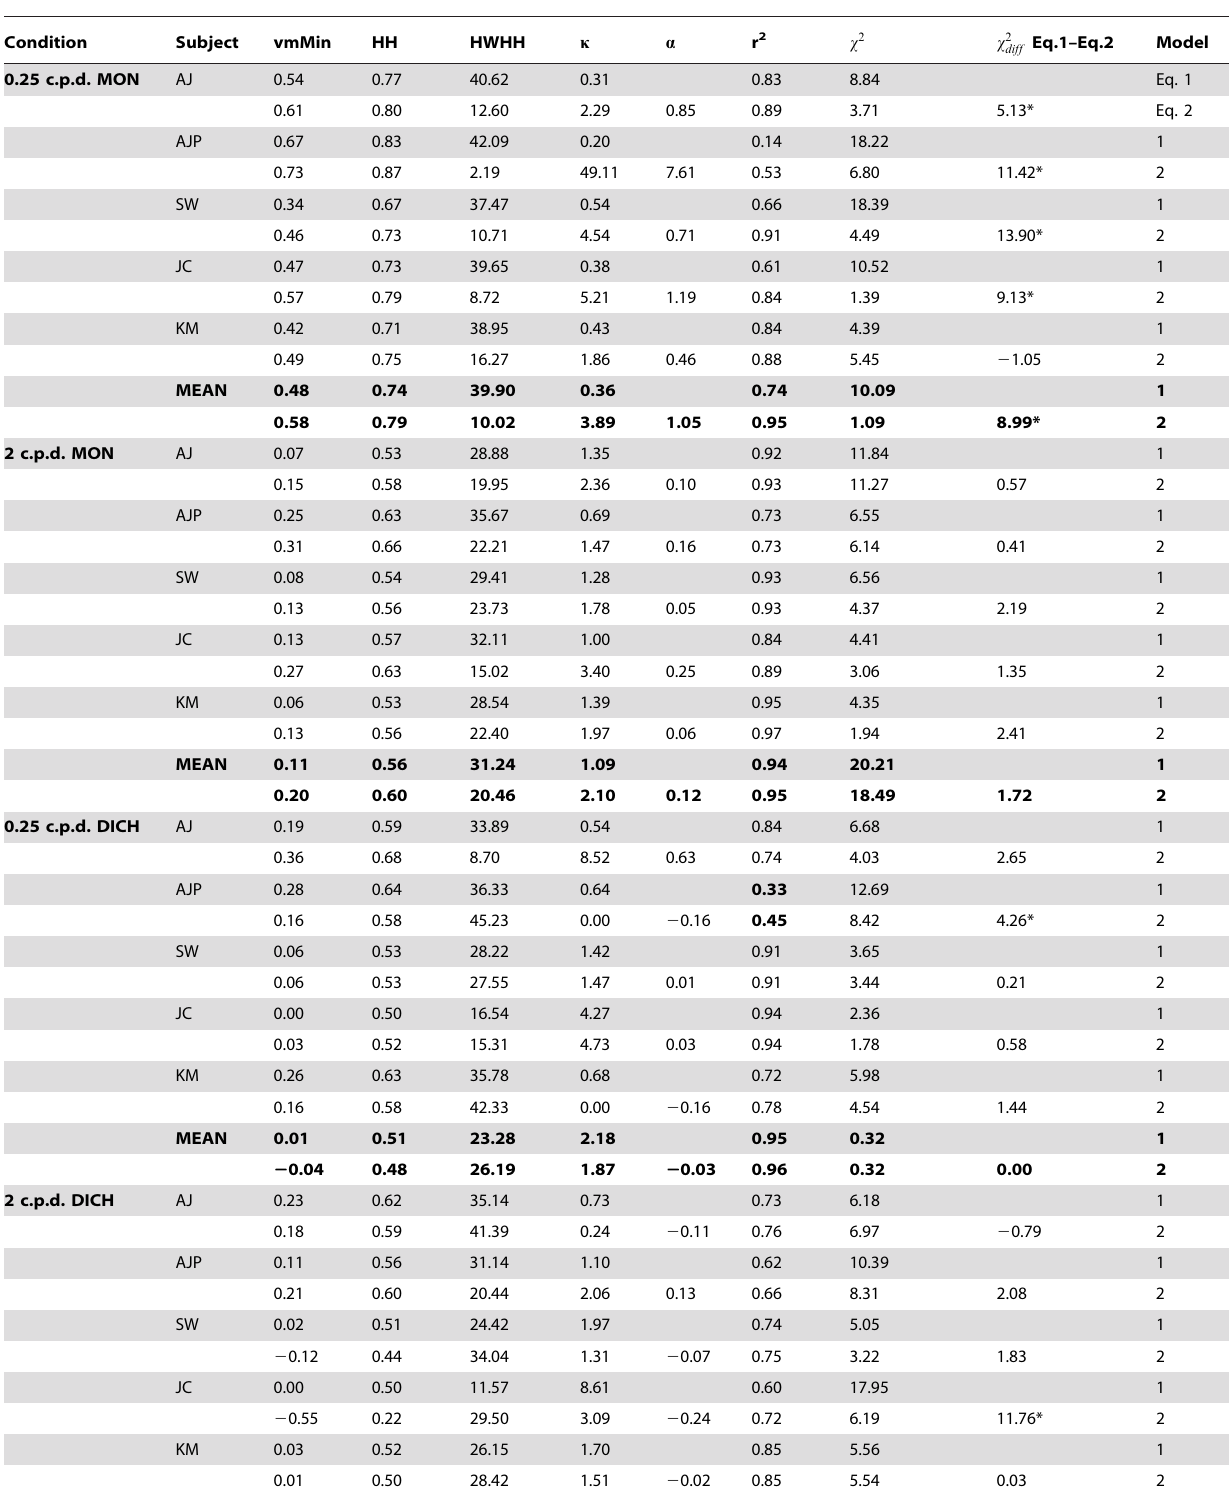
Table 2. Parametric, bandwidth and chi-square and estimates for each spatial frequency and ocular mode of presentation using Von Mises Equations 1 and 2.